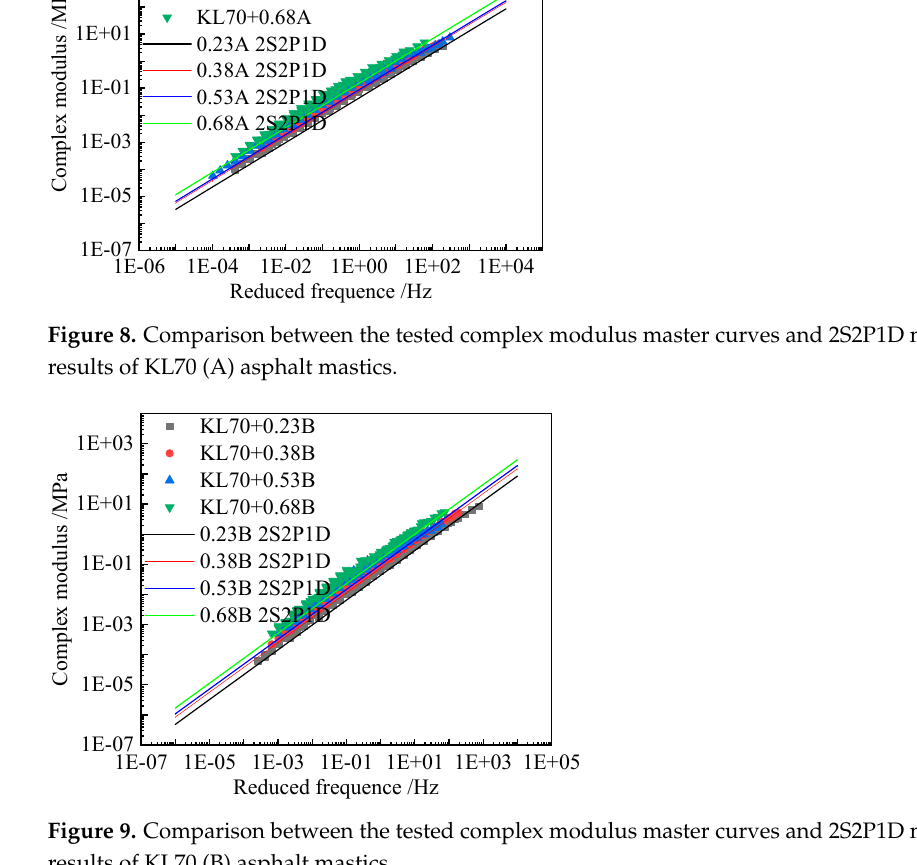
Figure 10. Relationship between h of binders and the corresponding mastics ( a , b ). ( b ) is more observed compare with ( a ). Table 4. Fitting result of the relation between h and effective filler volume fraction. Function